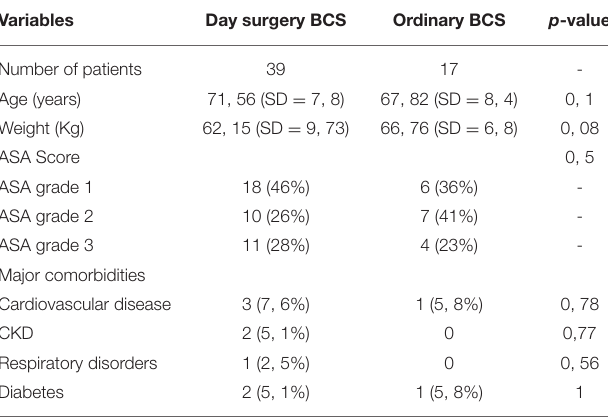
TABLE 2 | Patient characteristics of day surgery breast-conserving surgery (DS-BCS) vs. ordinary breast-conserving surgery (ORD-BCS). Variables